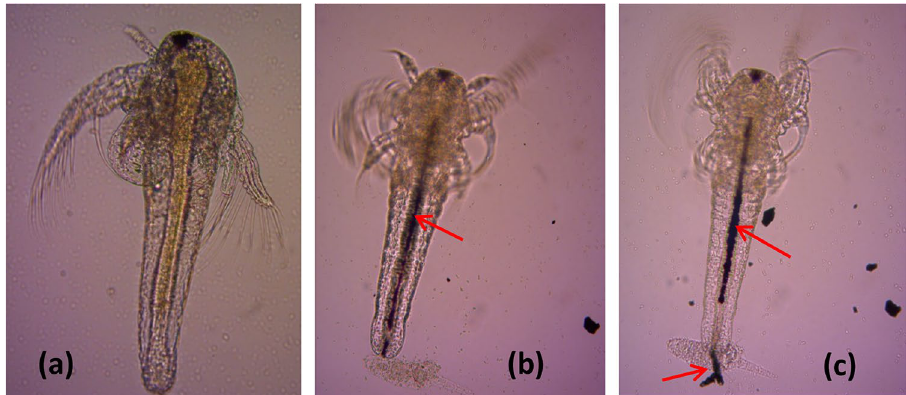
Figure 3. Optical microscope images of the ingestion of PANI/Ag (AMPSA)/GO QDs (red arrows) by Artemia salina larvae (×10 magnification) after 24 h exposure to 150 mg/L PANI/Ag (AMPSA)/GO QDs. The gut is empty in the control ( a ), PANI/Ag (AMPSA)/GO QDs is visible as a dark line inside the gut of treatment ( b ) and PANI/Ag (AMPSA)/GO QDs is excreted by Artemia salina larvae ( c